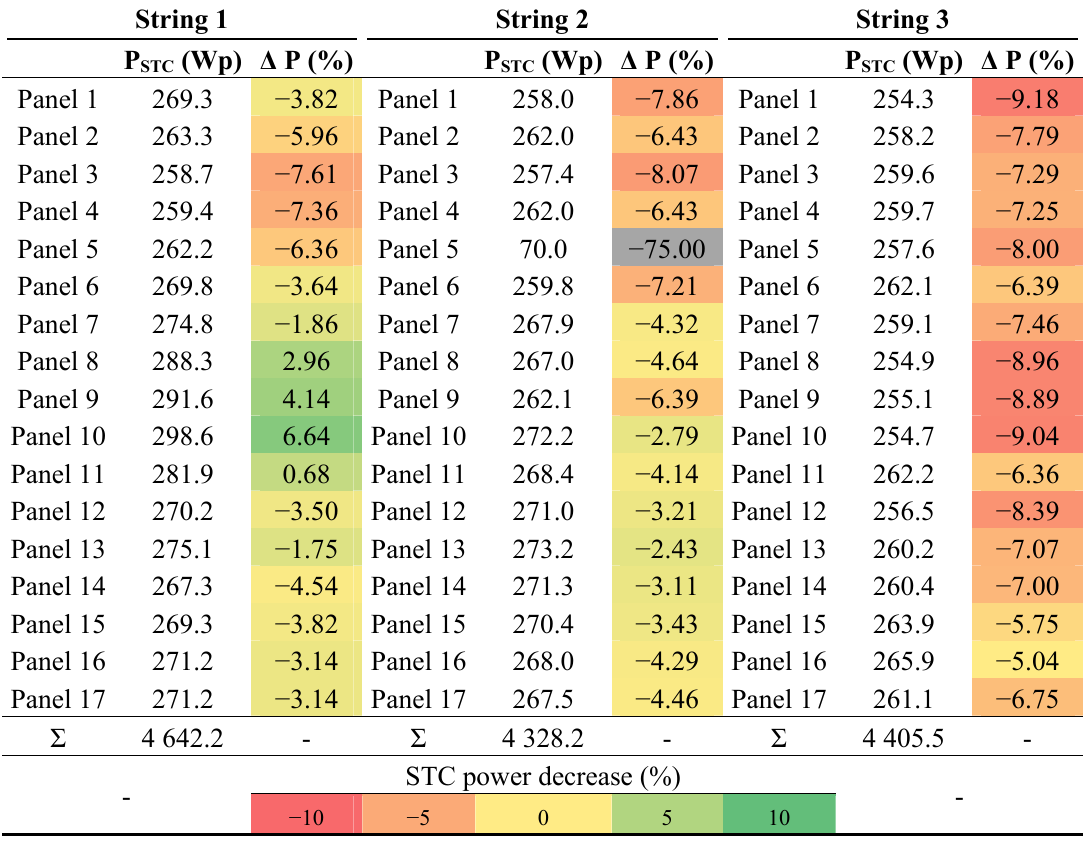
Table 2. Results of measuring the P STC of individual panels in selected strings in location 1